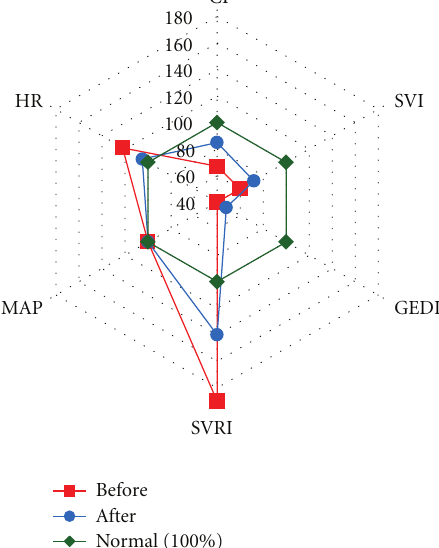
Figure 4: Variant STBI-a of hemodynamic reaction—patient no. 4 on the first day of monitoring before and after correction. Note. Hemodynamic parameters are presented with percents from the normal